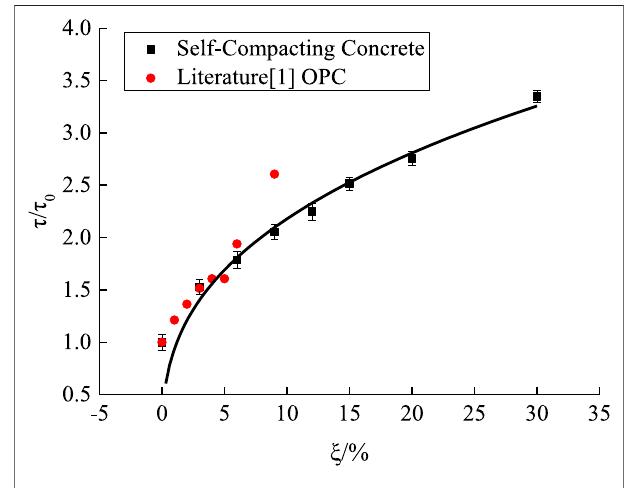
FIGURE 15 | The relation between the axial action and shear action of SCC under different axial compression